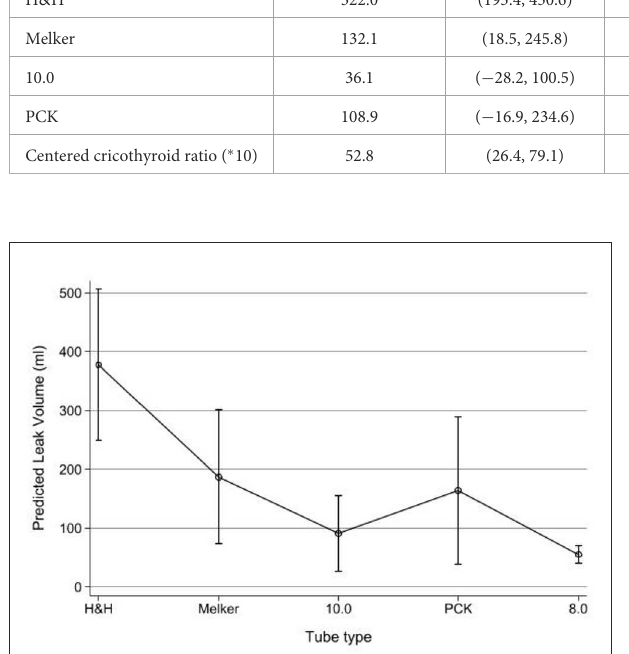
FIGURE5 Predicted tidal volume leak (ml) by tube type (dogs 4–10). Point estimates, whiskers = 95% CI.